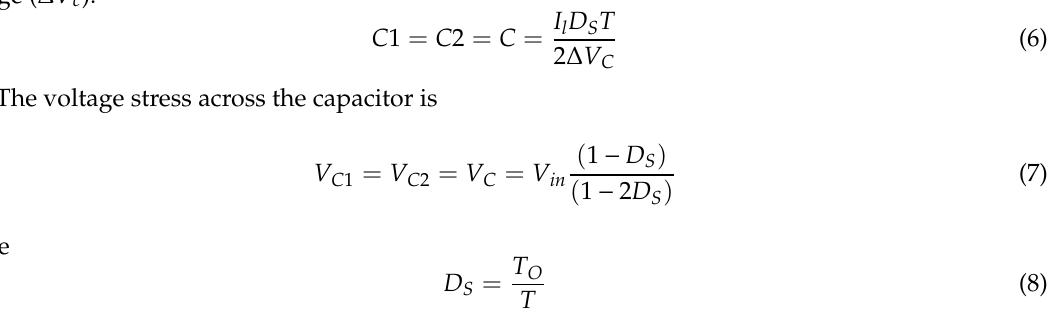
Figure 9. The hardware setup consisted of four IRFZ44 MOSFETS used as a switch (S1–S4) and four 4N35M optocouplers used to connect the microcontroller circuit with the converter switches.